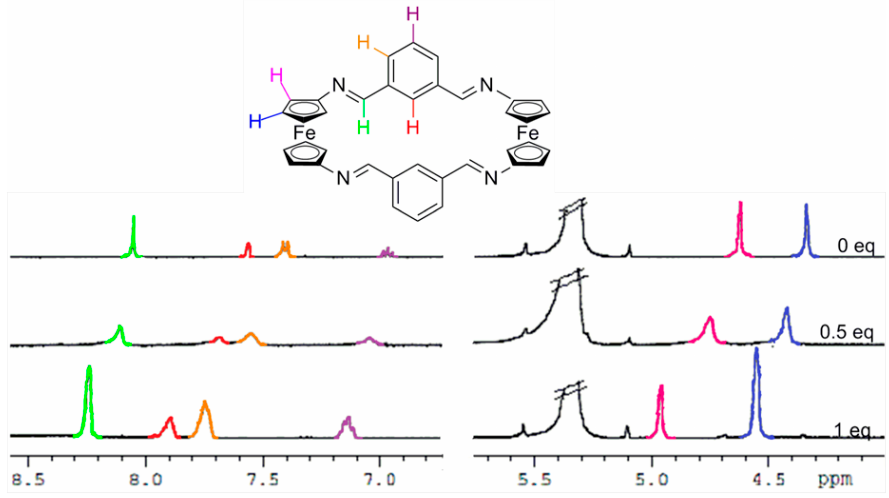
Table 2. Deshielding effect promoted in receptors 3 and 4 by the metal cations.